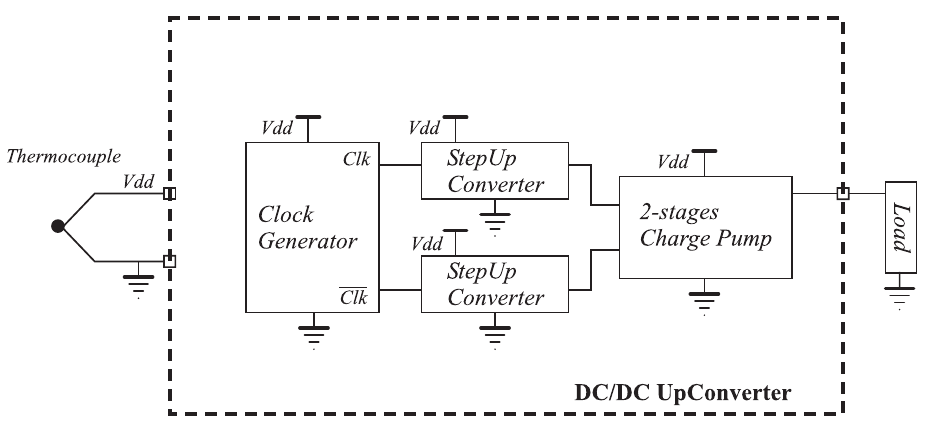
Figure 8. The hybrid converter presented in